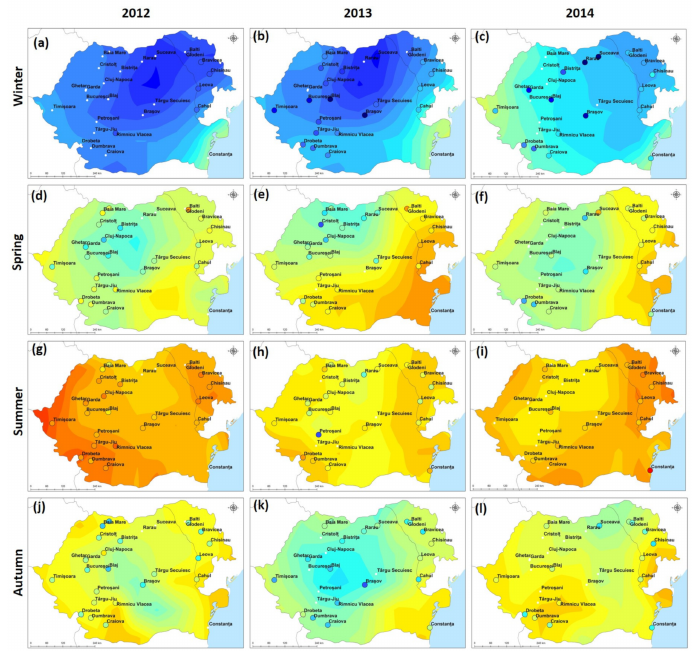
Figure 6. The spatio-temporal distribution of seasonal observed and modeled δ 18 O values over Romania and the Republic of Moldova over the period of January 2012 to December 2014. The measured data are represented as circles, and modeled data, based on the ECHAM5-wiso model output, are represented as shaded